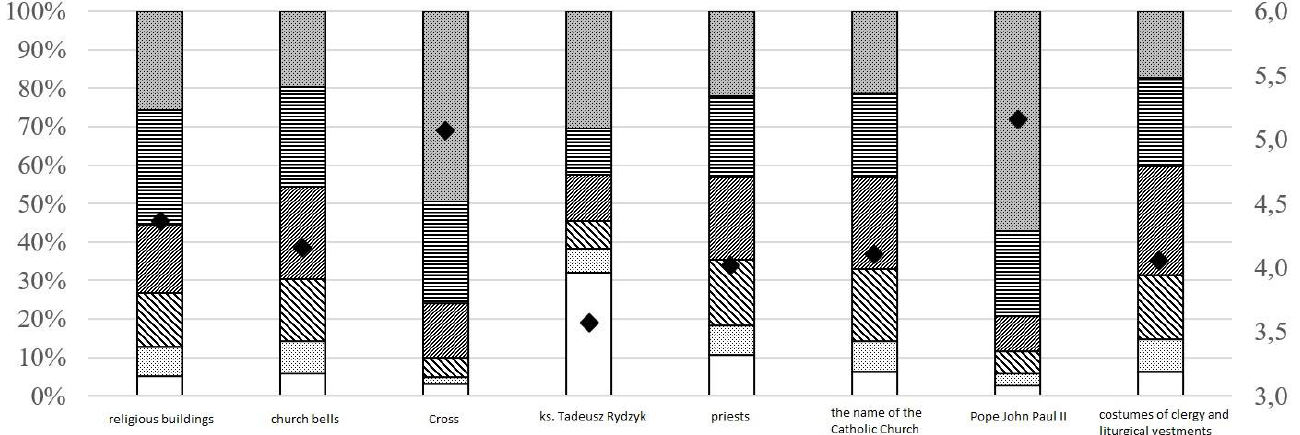
Figure 8. Branding characteristics of the Catholic Church in Poland. Source: authors’ own elaboration.